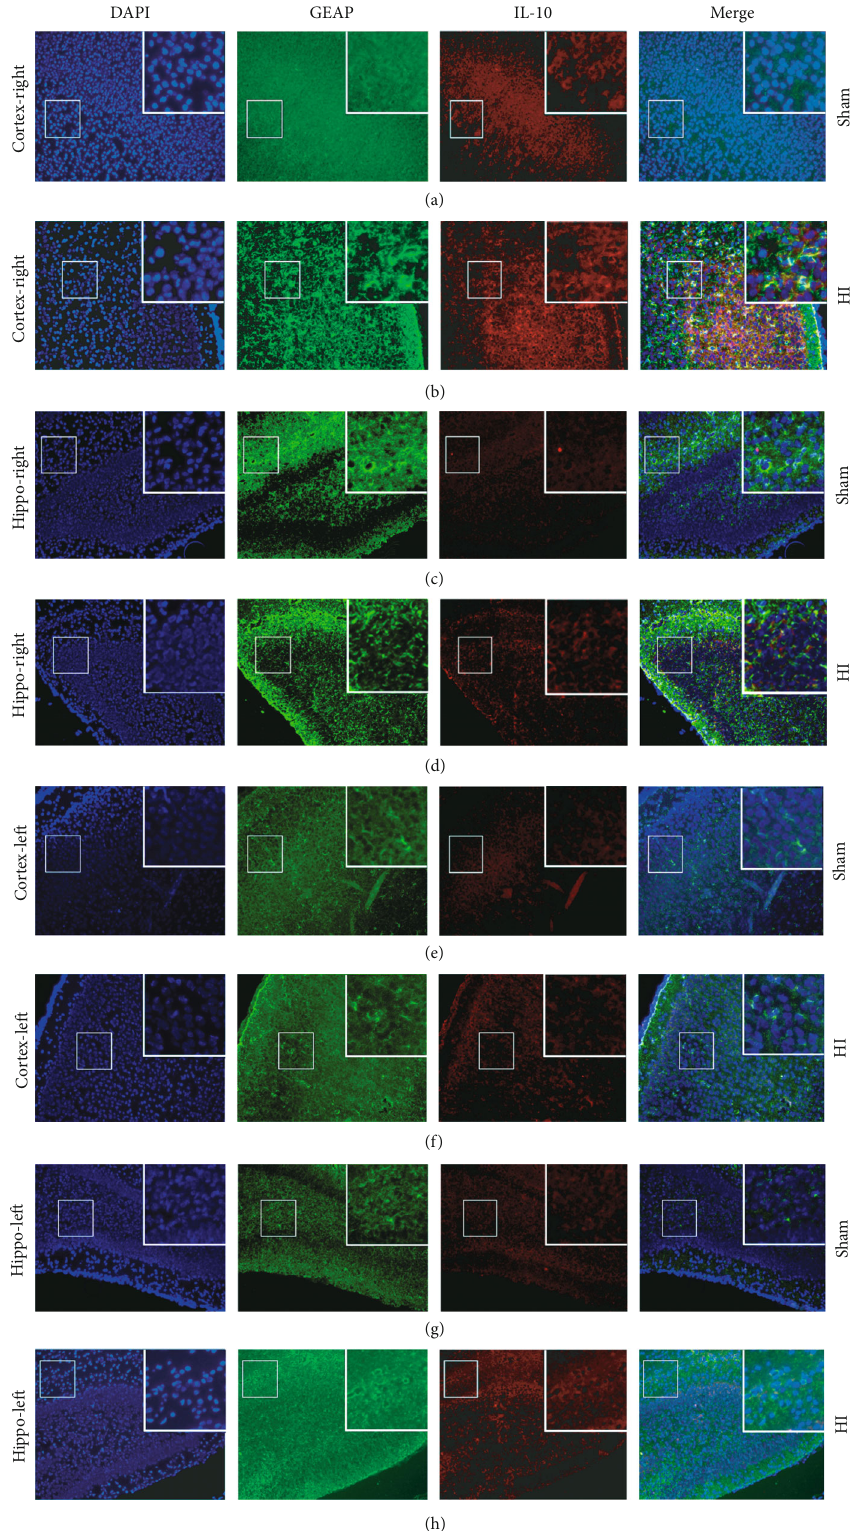
Figure 4: Immuno fl uorescence double staining of IL-10 and GFAP after HIE. (a) – (h) Immuno fl uorescence double staining of IL-10 and GFAP in the right and left cortex and hippocampus between sham and HI groups, respectively. DAPI (blue) stained all nuclei, IL-10- positive cells glowed red, and the GFAP-positive astrocytes glowed green. Scale bar = 100 μ m . GFAP: glial fi brillary acidic protein; DAPI: 4 ′ ,6-diamidino-2-phenylindole; HI: hypoxia-ischemia; IL-10: interleukin 10; h: hour. N = 6